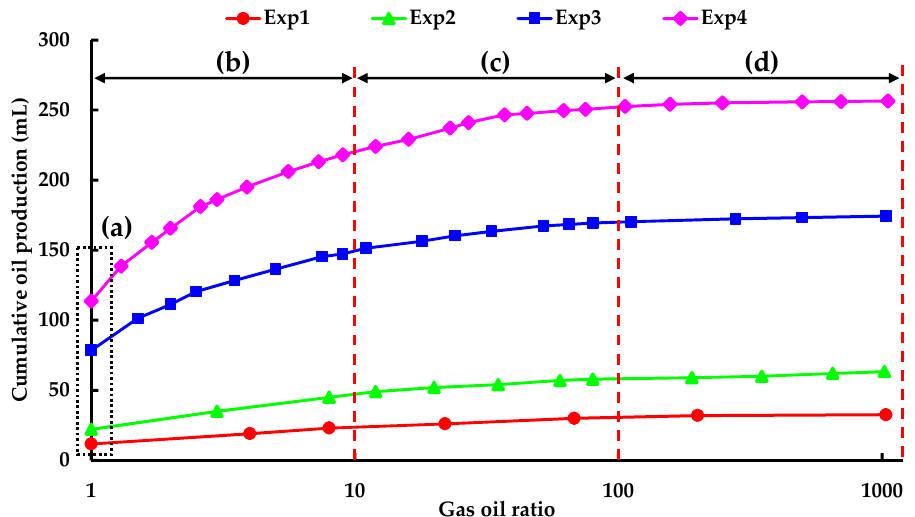
Figure 11. The cumulative oil production varies with the gas–oil ratio of different experiments: ( a ) production without gas produced; ( b ) production under low gas–oil ratio; ( c ) production at high gas–oil ratio; ( d ) production driven by the gas flow.